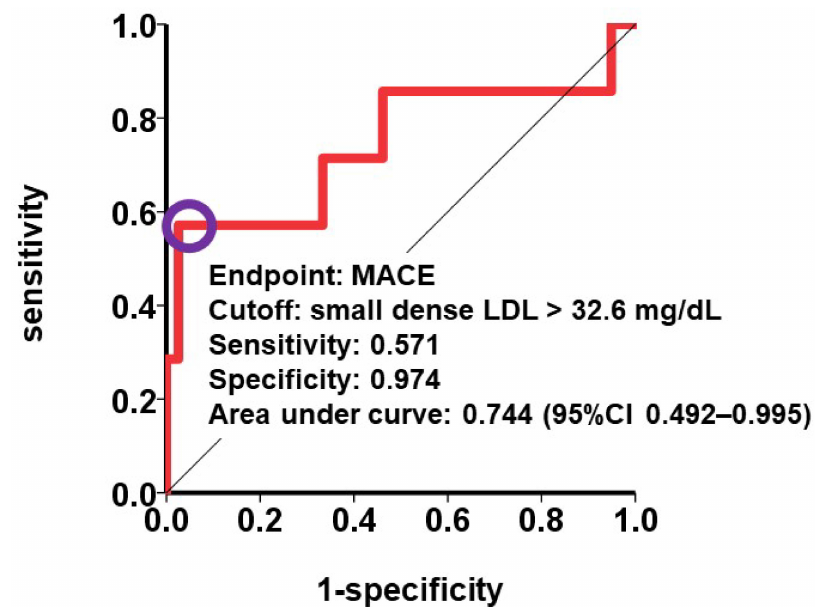
Figure 2. A cutoff of small dense LDL cholesterol to predict incidence of MACE. LDL, low-density lipoprotein; MACE, major adverse cardiac event.